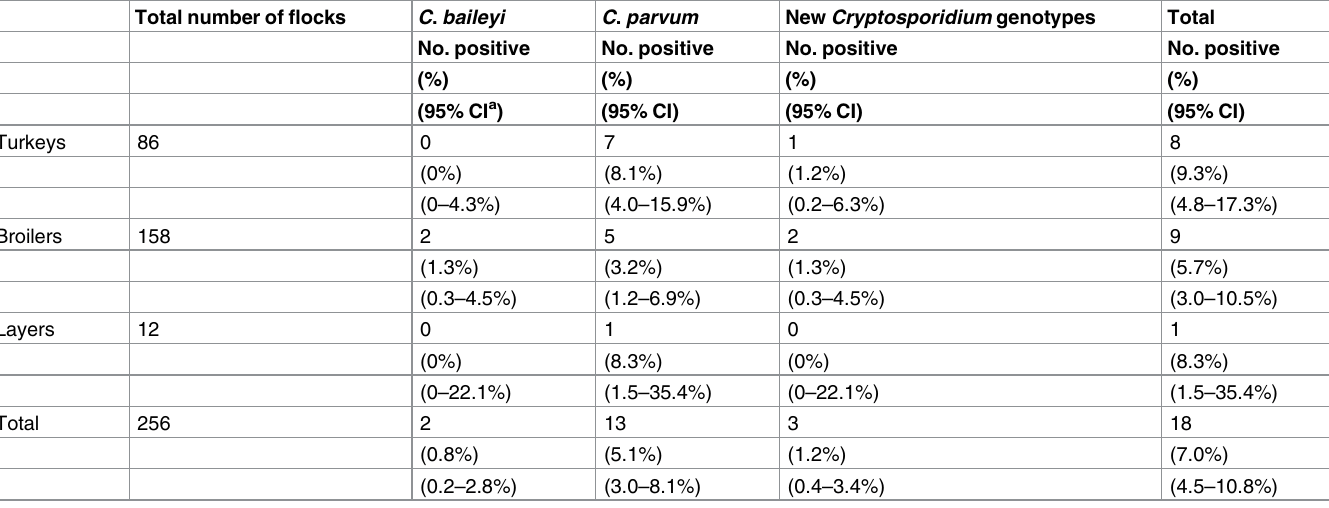
Table 1. Prevalence of Cryptosporidium spp. in different poultry